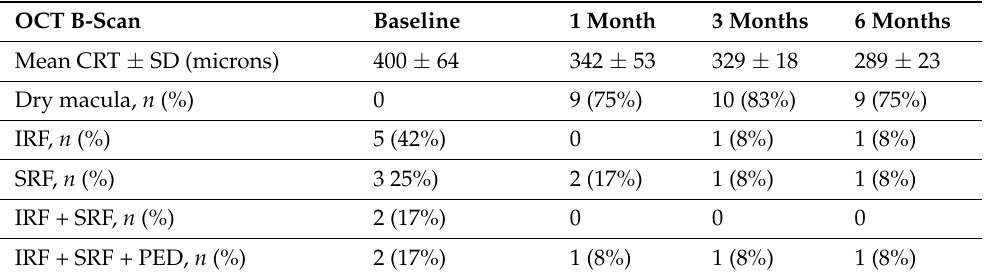
Table 2. Characteristics on optical coherence tomography (OCT) B-scan at baseline, at one month, three months, and six months after Brolucizumab